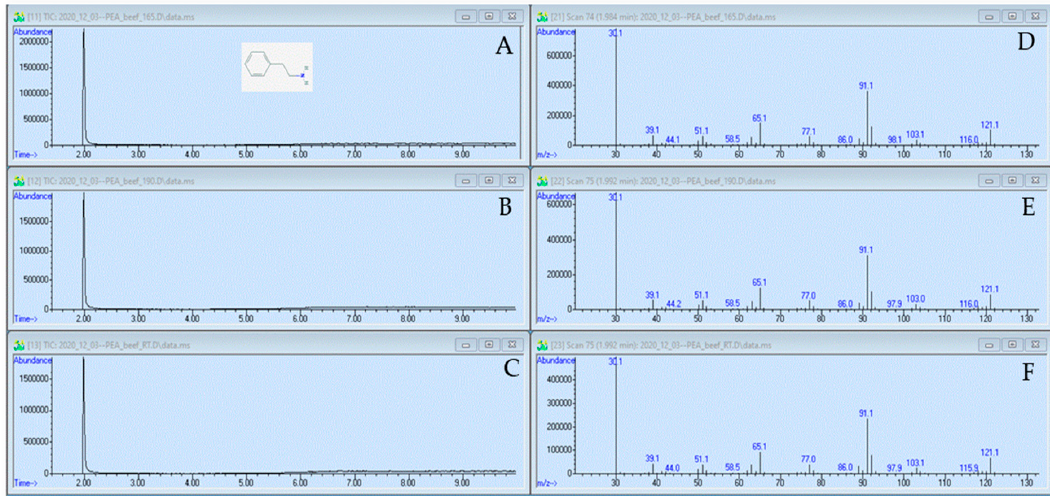
Figure 1. GC chromatograms of PEA and MS spectra of the 2 min peaks. Panel ( A – C ), chromatograms for PEA unheated (Panel ( A )), PEA heated to 73.9 °C (Panel ( B )), and PEA heated to 93.3 °C (Panel ( C )). The x-axis is retention time in min. Panels ( D – F) , spectra of the 2 min peaks from the respective GC. The x-axis is m/z , where m is the mass and z is the charge. The PEA molecule integrated in Panel A was taken from PubChem (https://pubchem.ncbi.nlm.nih.gov/compound/). The mass spectrum from our experimental PEA is practically identical to the SDBS pattern (Table 1). In both cases, the primary peak is at 30 m/z , while the second most in- tense peak is at 91 m/z . The near identity between our experimental and the SDBS spectra for PEA indicates that the 2 min peak from the GC contains pure PEA. The qualitative comparison of the chromatograms from the three samples (Figure 1A–C) leads to the ob- servation that heating did not yield new peaks for PEA, indicating that PEA did not pro- duce novel compounds during heating in beef broth. To make the statement that the quantity of PEA was not reduced by heating the com- pounds, we performed a quantitative analysis of the 2 min peaks from the GC. The areas of the peaks were determined by integrations from four replicate experiments and were calculated to PEA concentration in µmol mL − 1 with a calibration curve. Averages and standard deviations were 93 µmol mL − 1 ± 5.4% for the unheated sample, 100 µmol mL − 1 ± 3.3% for the 73.9 °C sample, and 98 µmol mL − 1 ± 3.9% for the 93.3 °C sample. Interestingly, there appeared to be a small increase of 8.5% for the 73.9 °C sample and 6.9% for the 93.3 °C sample. In any case, there was no decrease in the PEA concentration due to the heating process. We conclude that the amount of PEA within the 121.1 amu peak did not decrease during heating. To determine whether heat degradation of the anti-microbial may be dependent on the concentration of beef broth, three identical solutions of PEA-HCl in 5% beef broth were heat-treated as described above and analyzed with GC–MS. Across three replicate exper- iments, the PEA-HCl concentrations were calculated as follows: 640 µmol mL − 1 ± 8.2% for the unheated sample, 641 µmol mL − 1 ± 7.3% for the 73.9 °C sample, and 652 µmol mL − 1 ± 4% for the 93.3 °C sample. Differences in PEA concentration between samples equaled an increase of 0.16% for the 73.9 °C sample and 1.9% for the 93.3 °C sample. Increasing the concentration of beef broth did not cause heat degradation of PEA-HCl.